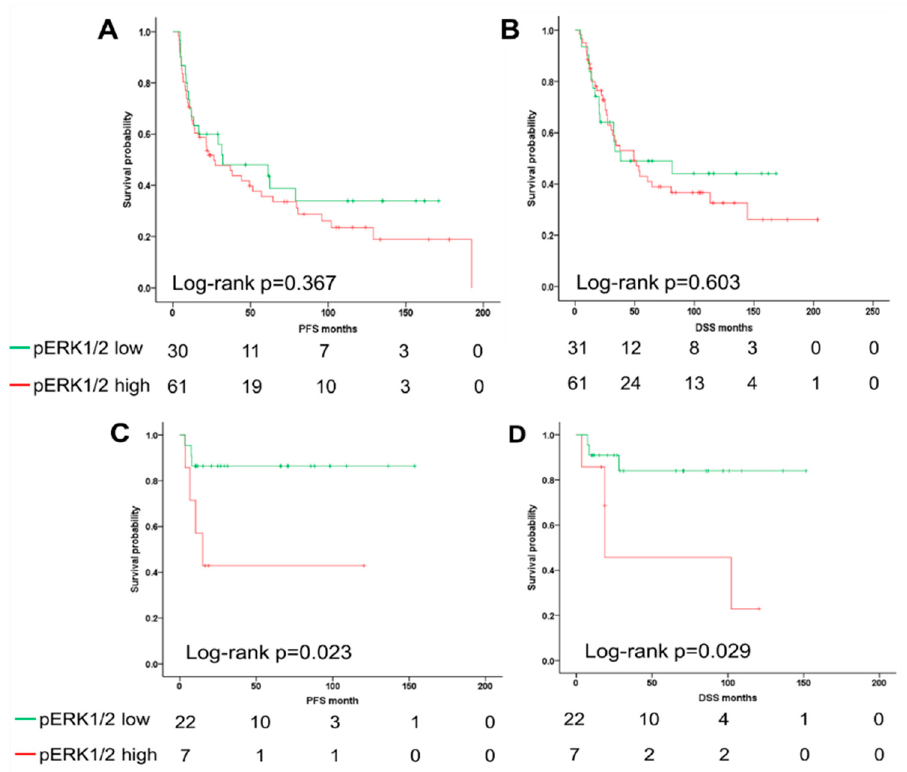
Figure 3. Correlation between pERK1 / 2 expression and survival of human papillomavirus (HPV)-negative and positive oropharyngeal squamous cell carcinoma (OPSCC) patients. Kaplan–Meier plots show the difference in disease-specific (DSS) and progression-free survival (PFS) between subgroups low and high pERK expression in HPV-negative ( A , B ) and positive ( C , D ) OPSCC patients. The number of survivors after a certain time interval (given in months) is displayed.